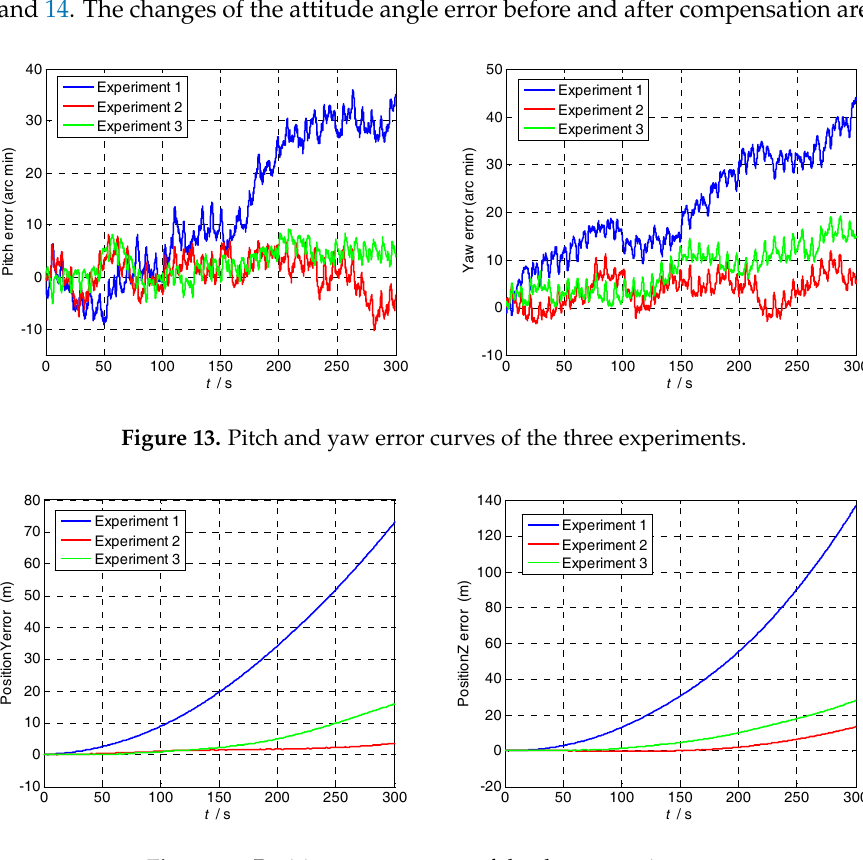
Figure 14. Position errors curves of the three experiments.